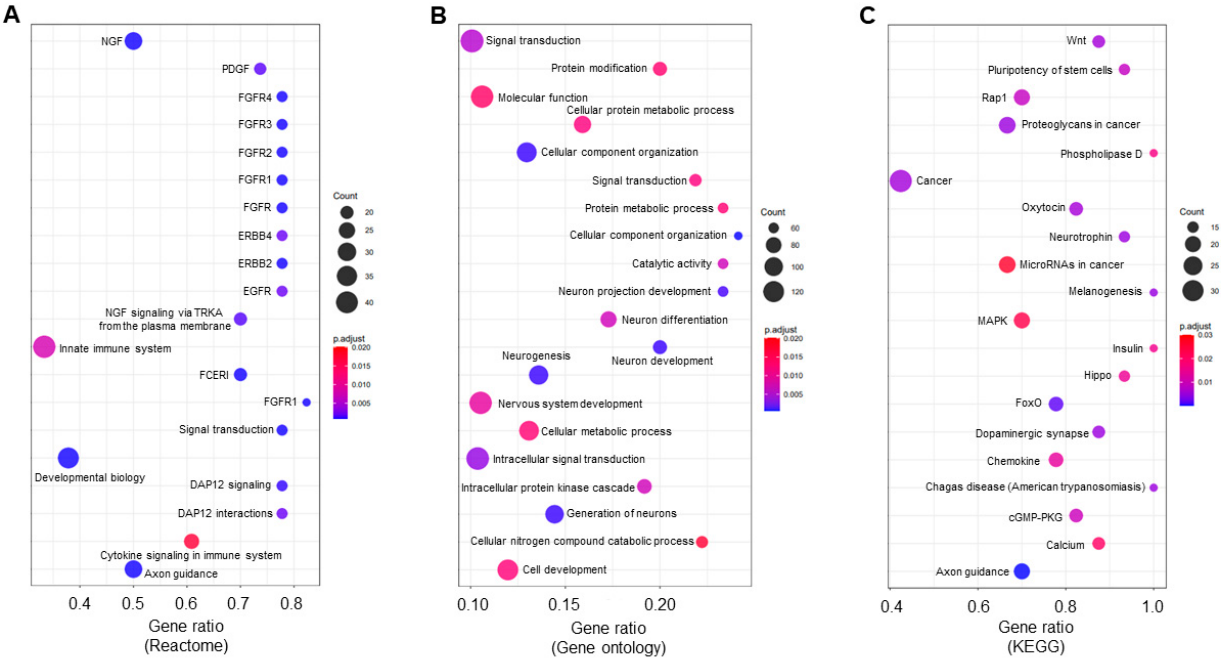
Figure 4. Bioinformatic analysis of downstream signaling and regulatory pathways by upregulated miRNAs with sepsis. Reactome ( A ), Gene Ontology ( B ), and KEGG ( C ) pathway analyses represented in three-way bubble plot analysis in the basis of gene ratio, gene count, and adjusted p -value. The top 20 pathways across the 3 downstream pathway analyses in IECs were regulated by 14 differentially expressed upregulated miRNAs with sepsis. The top 20 pathways across the 3 were selected by the rank of the number of hits. All pathways shown were filtered based on significant enrichment (adjusted p -value ≤ 0.05). Full names for pathways were provided in Supplementary Tables